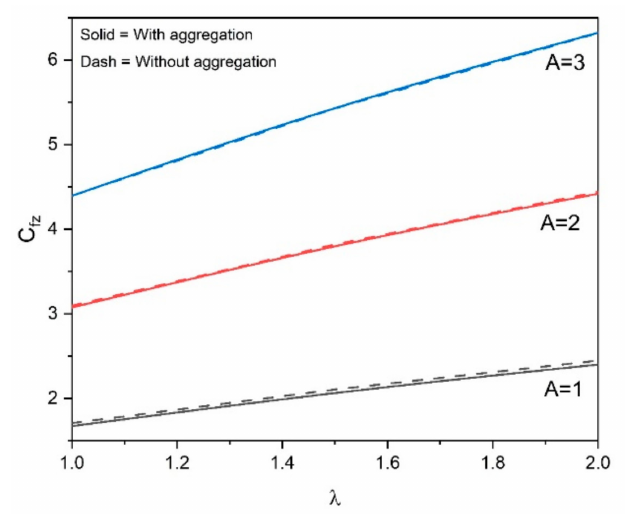
Figure 10. Influence of C fz on λ for numerous values of A